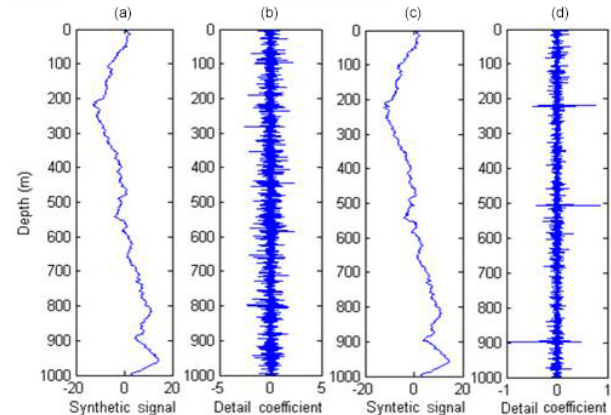
Figure 3. (a) Synthetic well log data over the fractureless well site, (b) discrete wavelet detail coefficient (DWC) of the fractureless well site, (c) synthetic well log data over the fractured well site, and (d) DWC of the fractured well